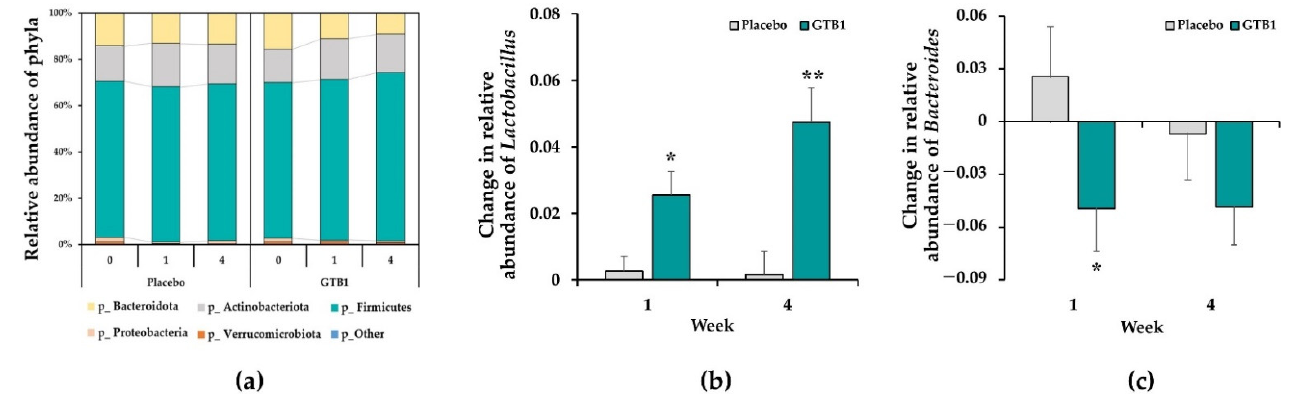
Figure 7. Fecal microbiota. ( a ) Proportions of various bacterial phyla comprising fecal microbiota. ( b ) Change in relative abundance of Lactobacillus . ( c ) Change in relative abundance of Bacteroides . Data are means ± SEM. * p < 0.05, ** p < 0.01 as determined by two-sample t -test.